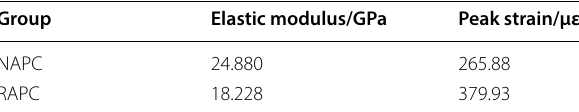
Table 6 Elastic modulus and peak strains of different aggregate pervious concretes.